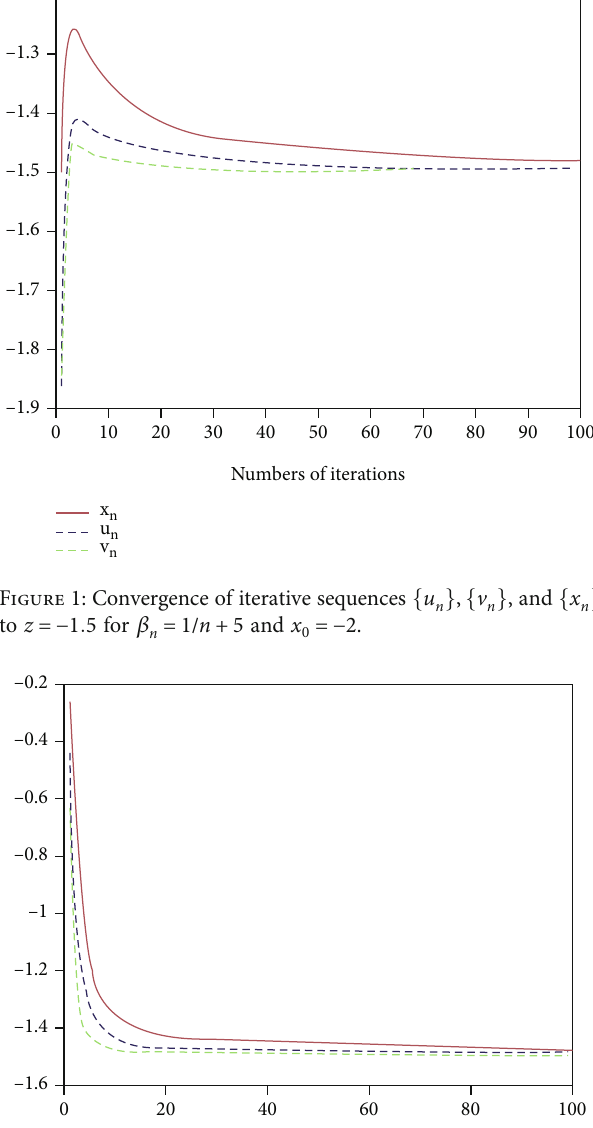
g , f v g , and f x n n